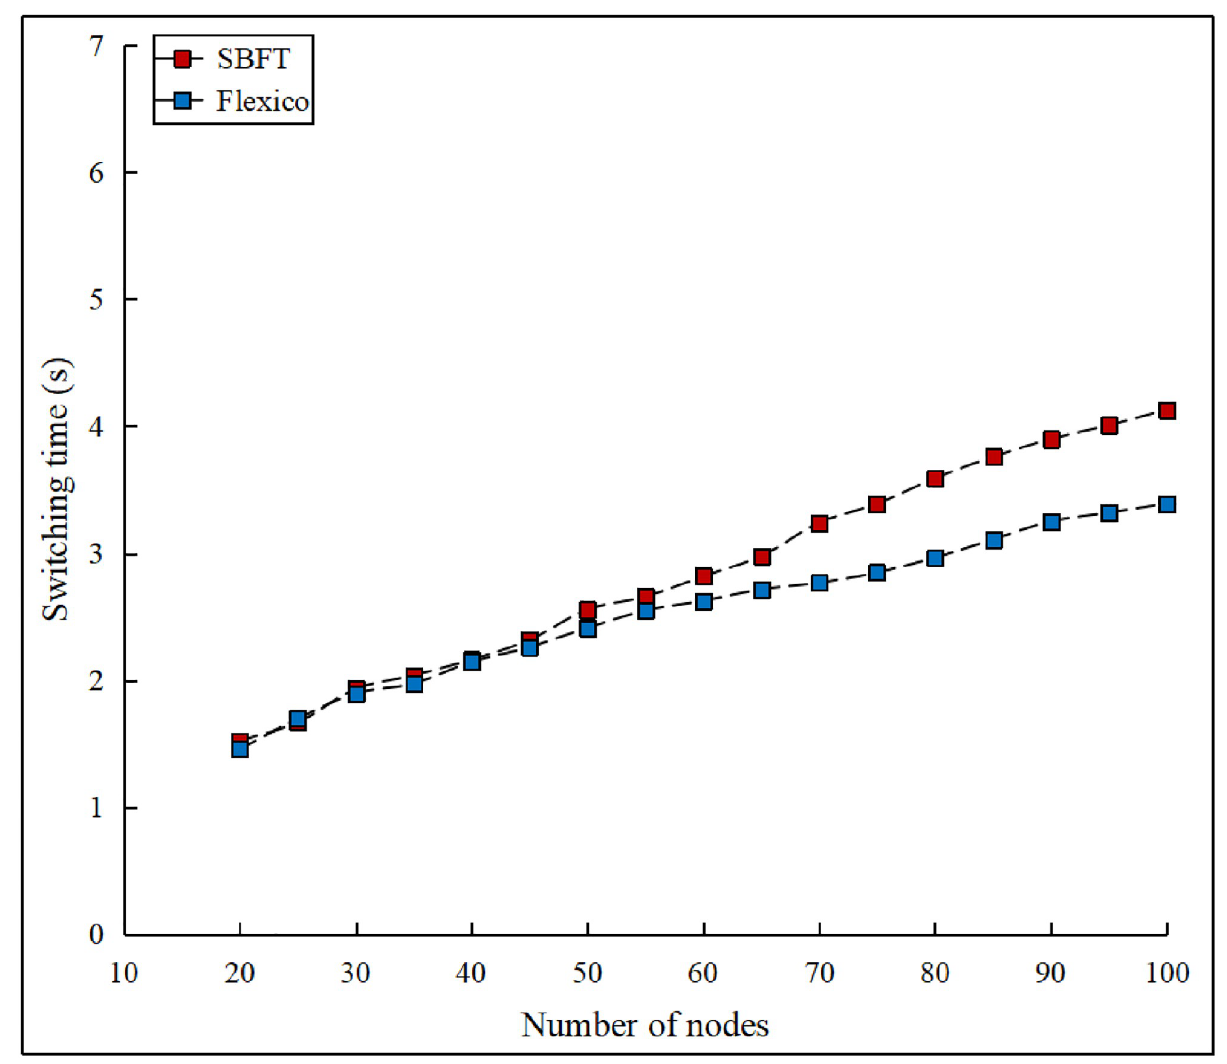
Fig 10. Protocol switching time comparison.